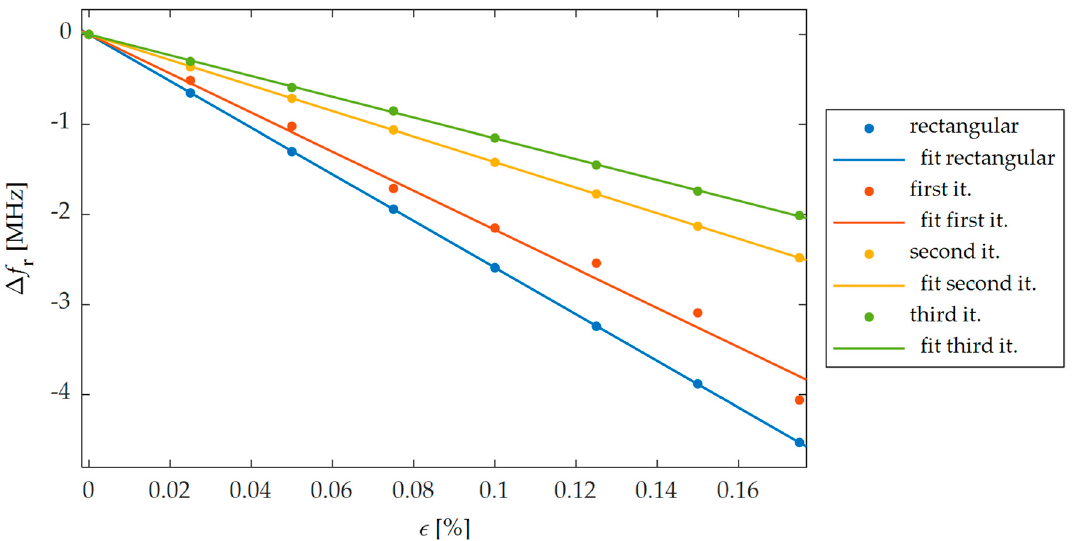
Figure 7. Dependencies between strain ε and shifts of resonant frequency ∆ f r for proposed sensors obtained in numerical analysis.